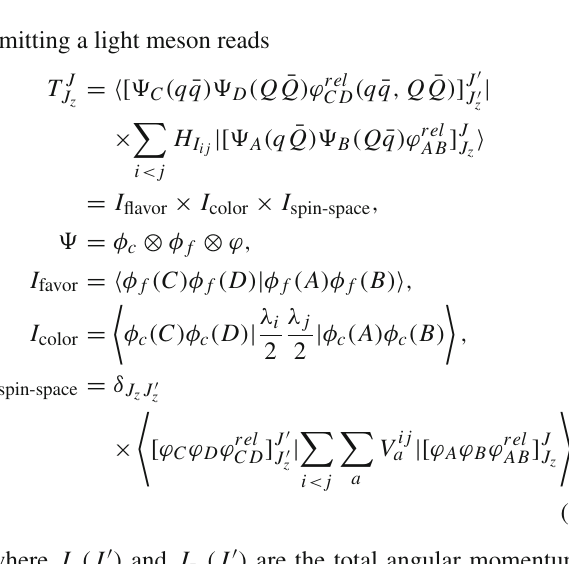
Fig. 2 Post diagram of scattering process AB →